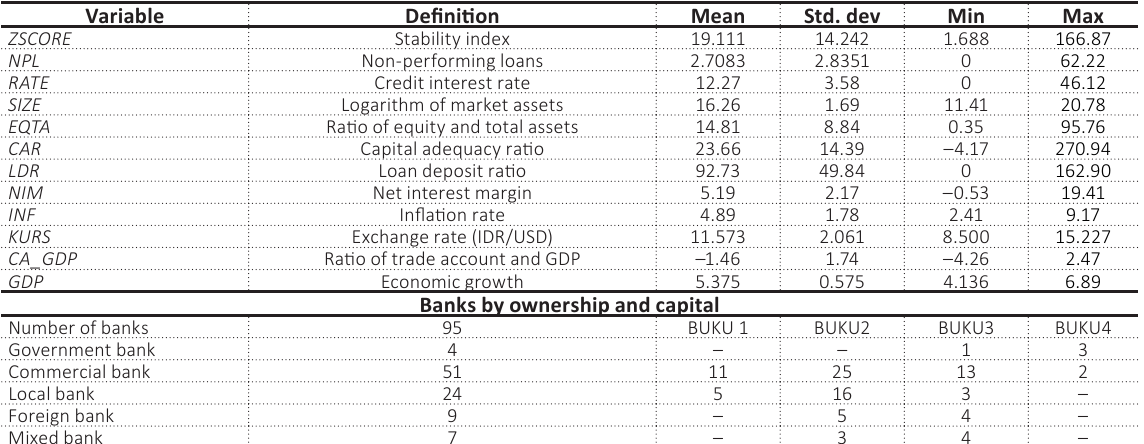
Table 2. Descriptive statistics of variables